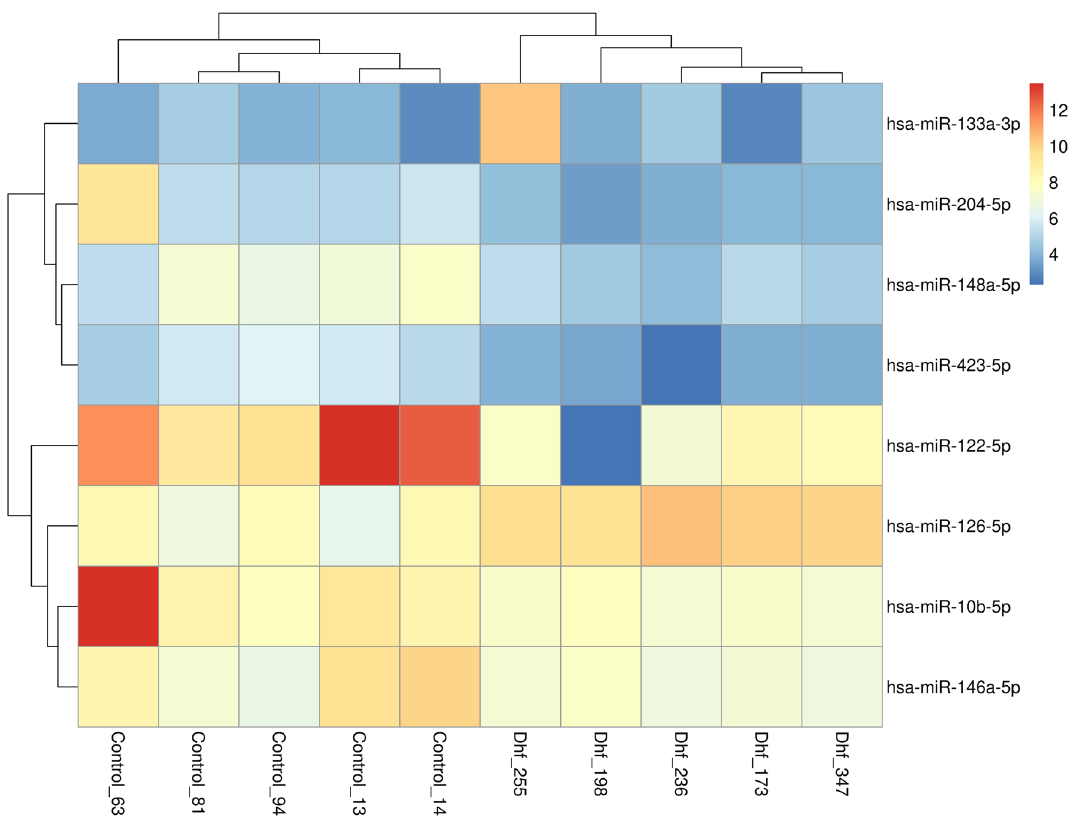
Figure 1. Heatmap analysis of all differentially expressed microRNAs detected in this study using miRNA-seq shows a clear separation of DHF and control samples. The scale bar is in log2(CPM).